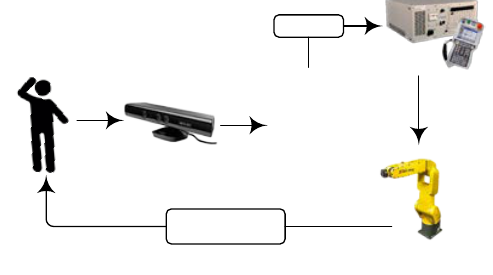
Fig. 1. Robot control